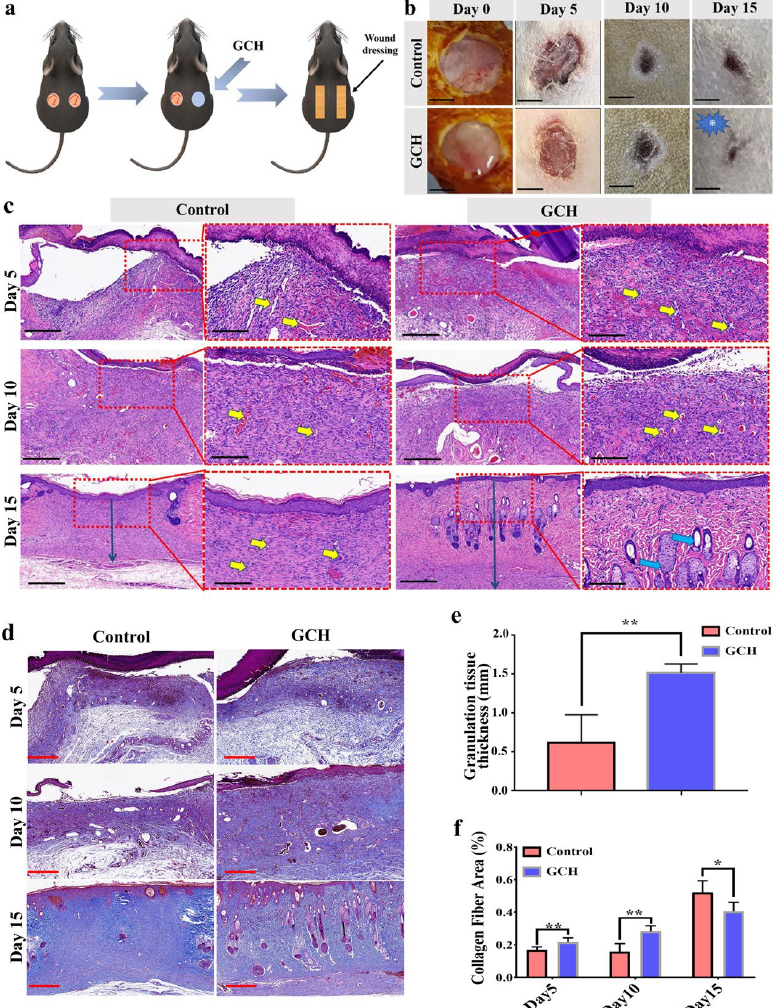
Figure 5 . In vivo study using rats as the model animal, histological morphology, and Masson stain- ing. ( a ) Schematic illustrations of full-thickness skin wound rat model using GCH. ( b ) Photographs representing the healing progress of the wounds. Scale bar: 500 µ m. ( c ) Histomorphological evalu- ation of wound regeneration for GCH and control group on 5th, 10th, and 15th day. A red dotted rectangular box corresponds to high magnification images of the wound central area. Vessels in the granulation tissue are signposted by yellow arrows, and hair follicles are signposted by blue arrows. The granulation tissue thickness is signposted by black arrows.(Left: 4 × objective, scale bar: 400 µ m; right: 10 × objective, scale bar: 200 µ m.) ( d ) Representative images of skin tissue sections after Masson trichrome staining on the 5th, 10th, and 15th day of each group; blue color indicates collagen. Scale bar: 400 µ m. ( e ) Statistical graph of granulation tissue thickness for each group on 15th day. ( f ) Quantified analysis of the collagen fiber area percentage. (Statistical significance was calculated via Student’s t -test. * p < 0.05, ** p < 0.01.) All data are presented as mean ±